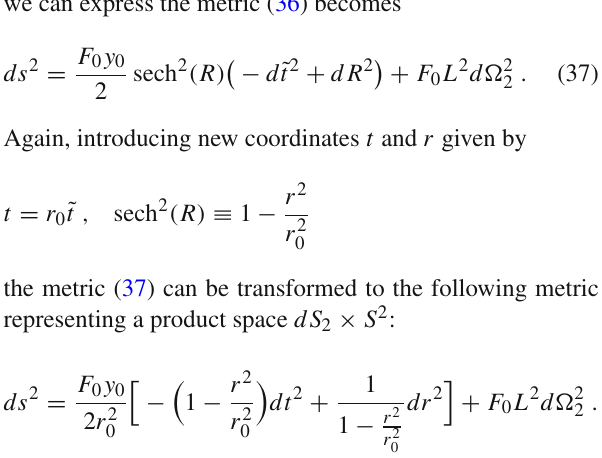
Fig. 1 The burgundy, green, and white regions show the range of couplings on which Eq. (16) has one, two, and no positive root of W 2 respectively. The solid lines represent the configurations with double